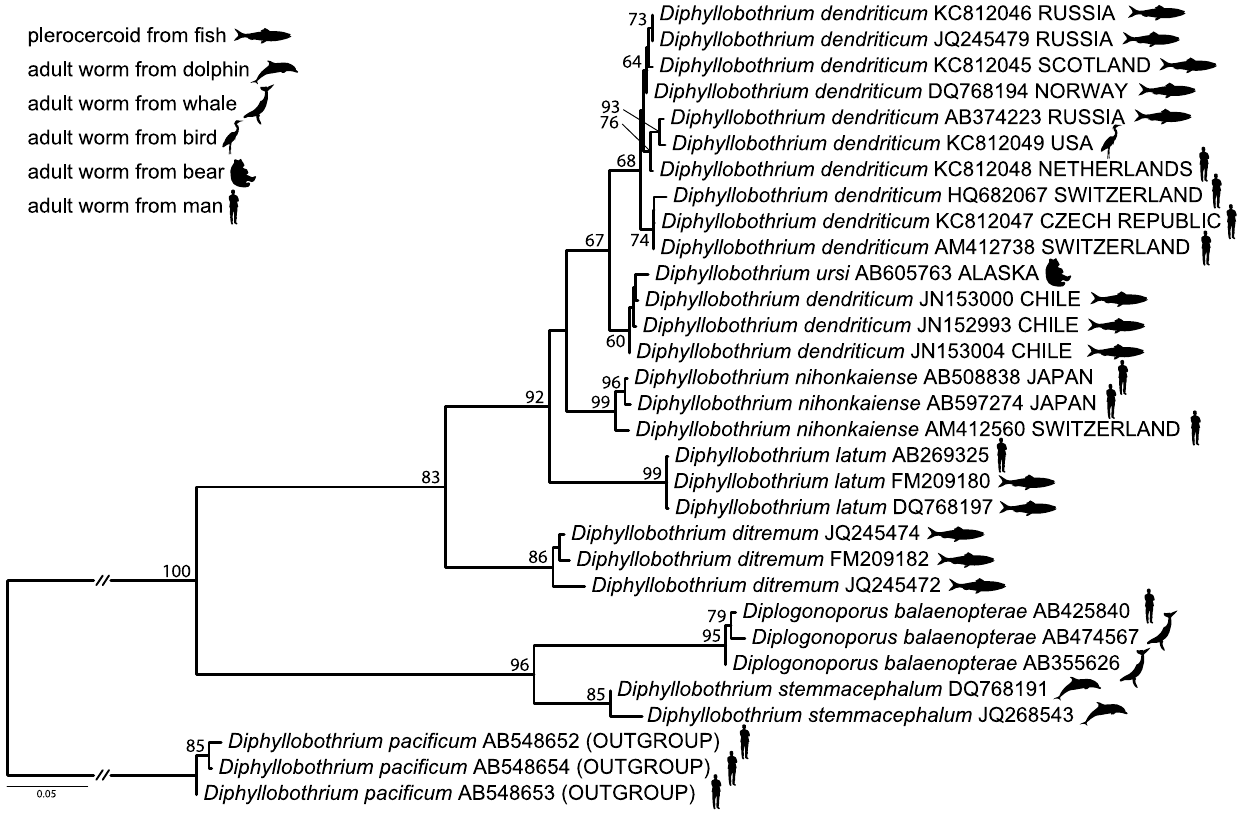
Figure 1. Maximum likelihood (ML) estimate of Diphyllobothrium dendriticum phylogenetic relationships based on currently available cox 1 sequences of human-infecting Diphyllobothrium species and their close relatives computed in Garli 2.0. Nucleotide data matrix was 1563 bp long; codon positions were analyzed separately according to the partition scheme and models (TrN + I) (F81) (TrN + I + G) chosen according to the BIC in PartitionFinder 1.0.1. Nodal support values depict bootstrap support proportions . 50 based on 1,000 repetitions estimated in Garli. Note that the D. pacificum branch was shortened by a factor of two. Newly obtained sequences are shown in bold type; country of origin is listed for D. dendriticum infections.